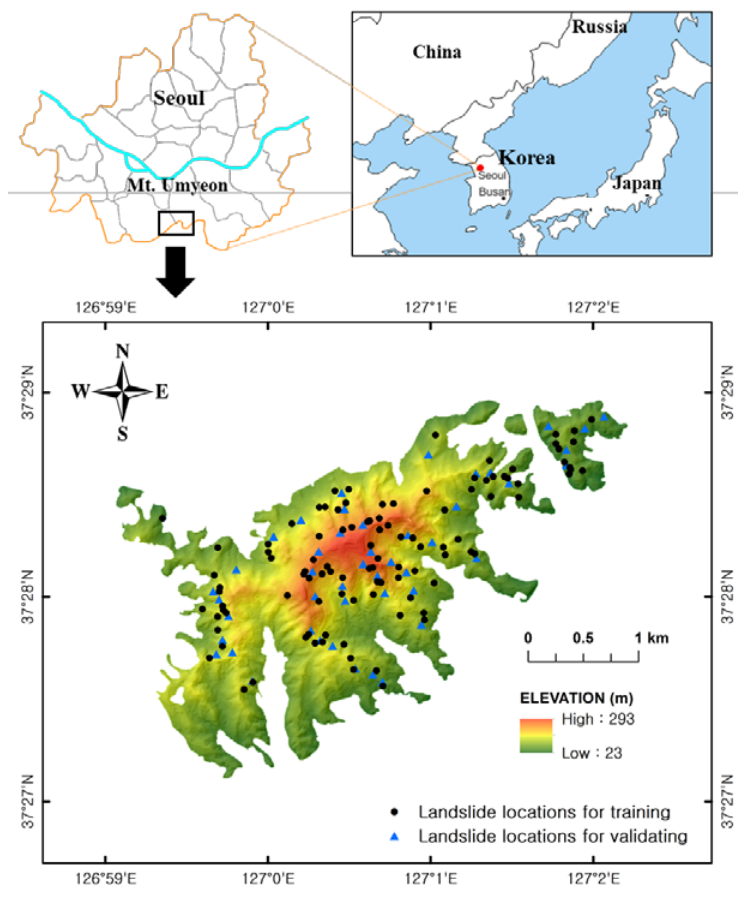
Figure 1. Landslide locations in the study area.